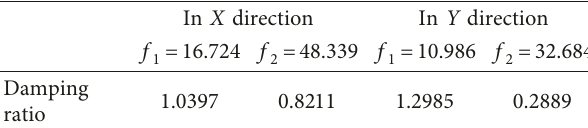
Table 2: Damping ratio of the experimental model (%). In X